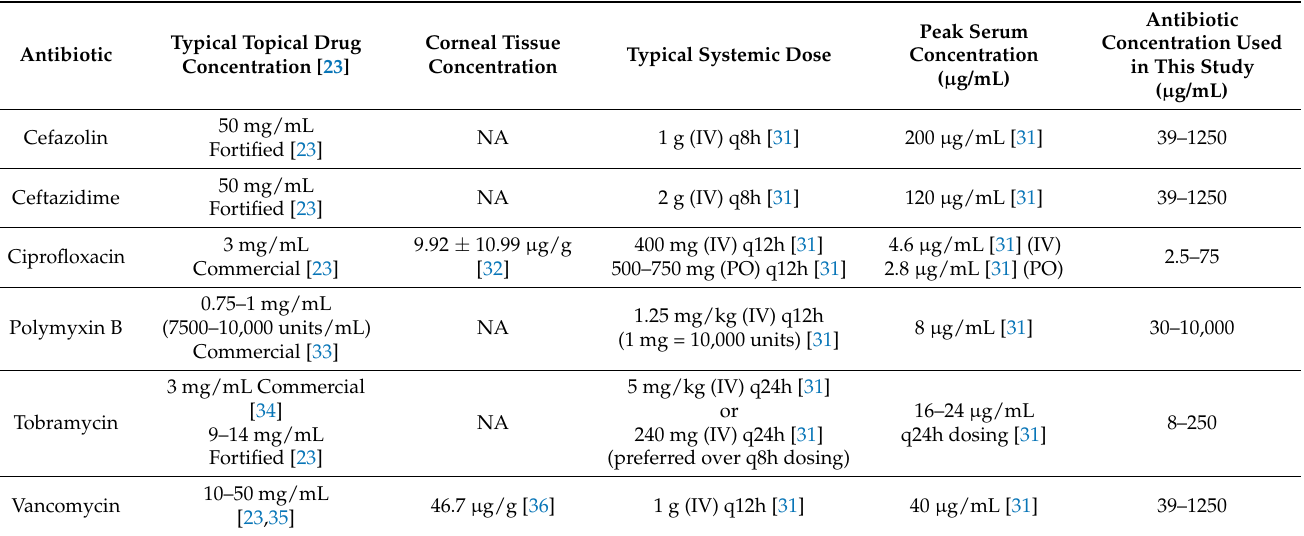
Table 1. Characteristics of antibiotics used in this study.